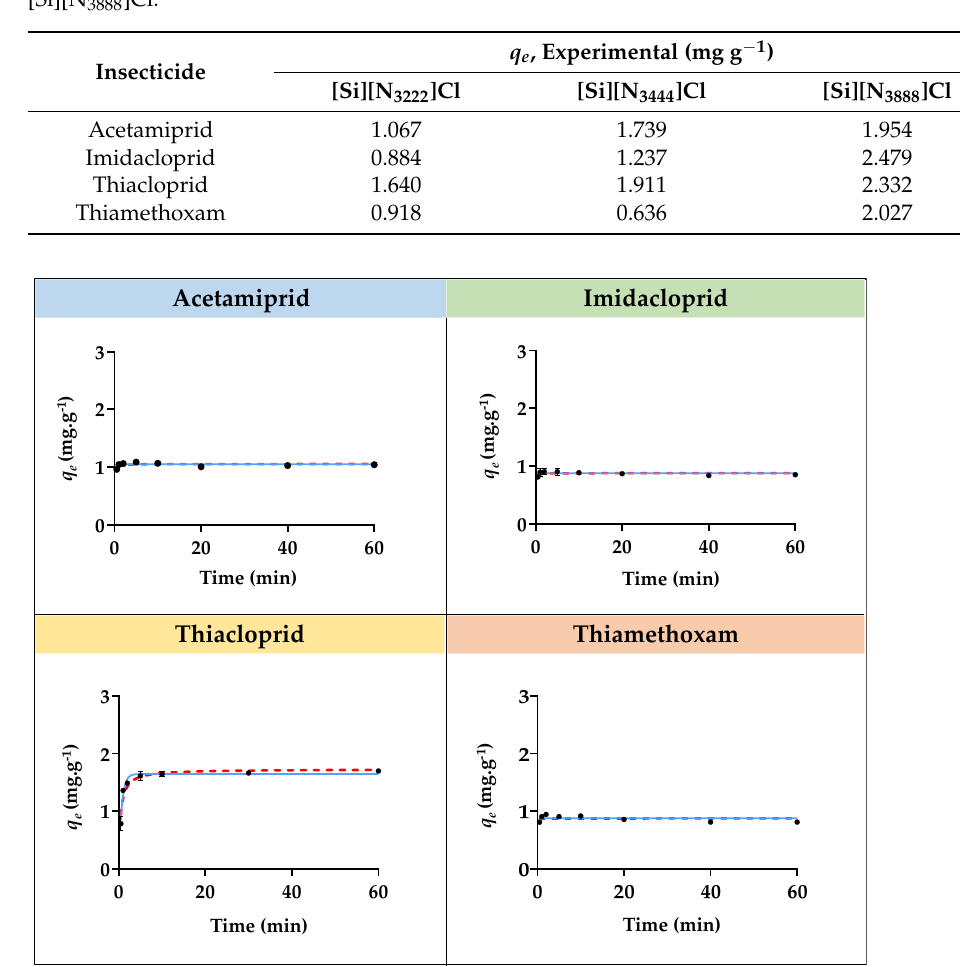
Figure 1. Adsorption kinetic curves for acetamiprid, imidacloprid, thiacloprid, and thiamethoxam with [Si][N 3222 ]Cl. The black dots correspond to the experimental data, the continuous blue line corresponds to the fitting of the experimental data with the Pseudo first-order model, and the red dashed line corresponds to the fitting with the Pseudo second ‐ order model.